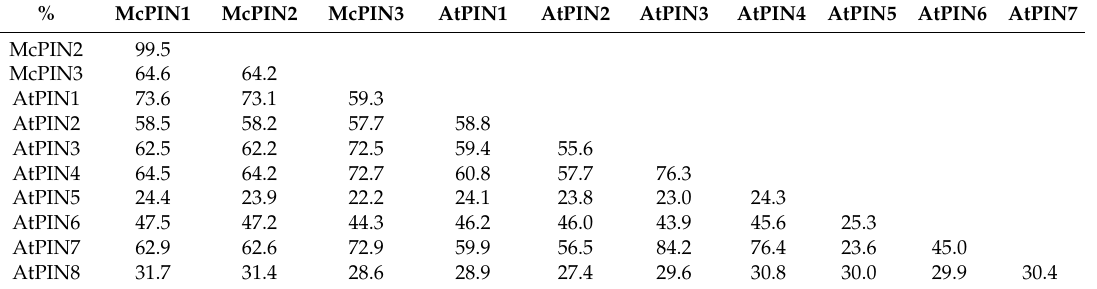
Table 2. Pairwise comparison of the amino acid sequence identity from auxin efflux carriers from bitter gourd (McPIN1 to 3), and Arabidopsis (PIN1, PIN2, PIN3, PIN4, PIN5, PIN6, PIN7, and PIN8) using the AlignX program of Vector NTI Suite 9.0 software. GenBank accession numbers are AF247004 (McPIN1), AF246995 (McPIN2), AF247005 (McPIN3), AF089084 (AtPIN1),